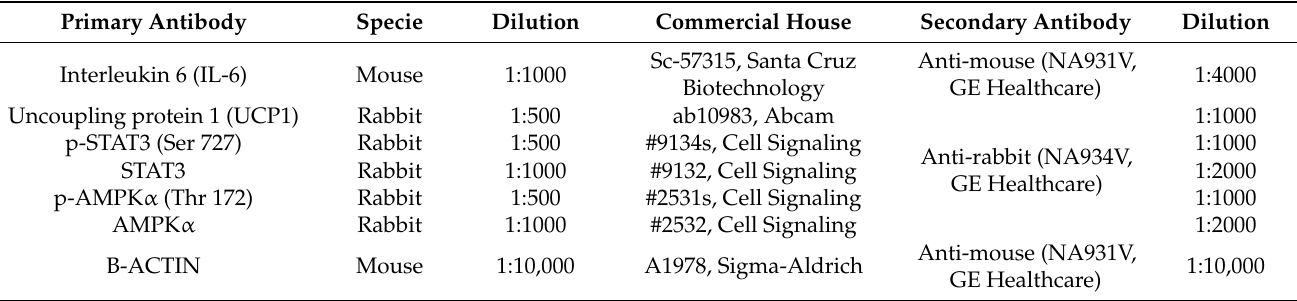
Table 2. Antibodies used for Western Blot